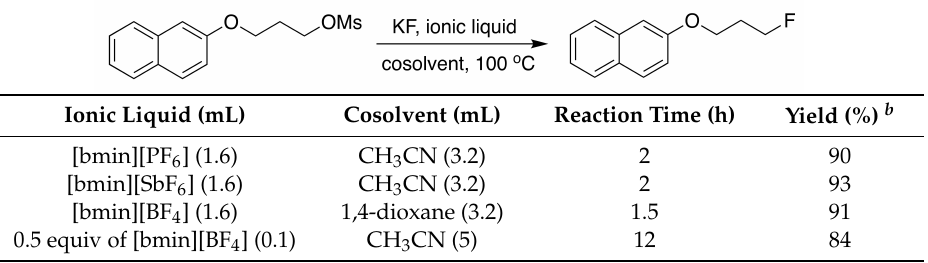
Table 1. Fluorinations using KF in various ionic liquids and cosolvents a .